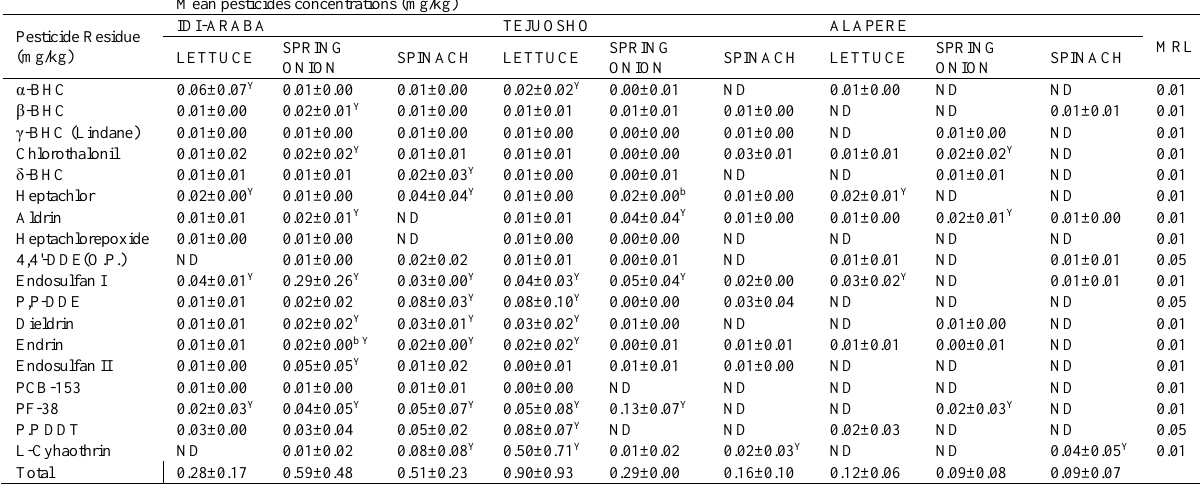
Table 1. Residual organochlorine concentrations in shoots of sampled salad vegetables Mean pesticides concentrations